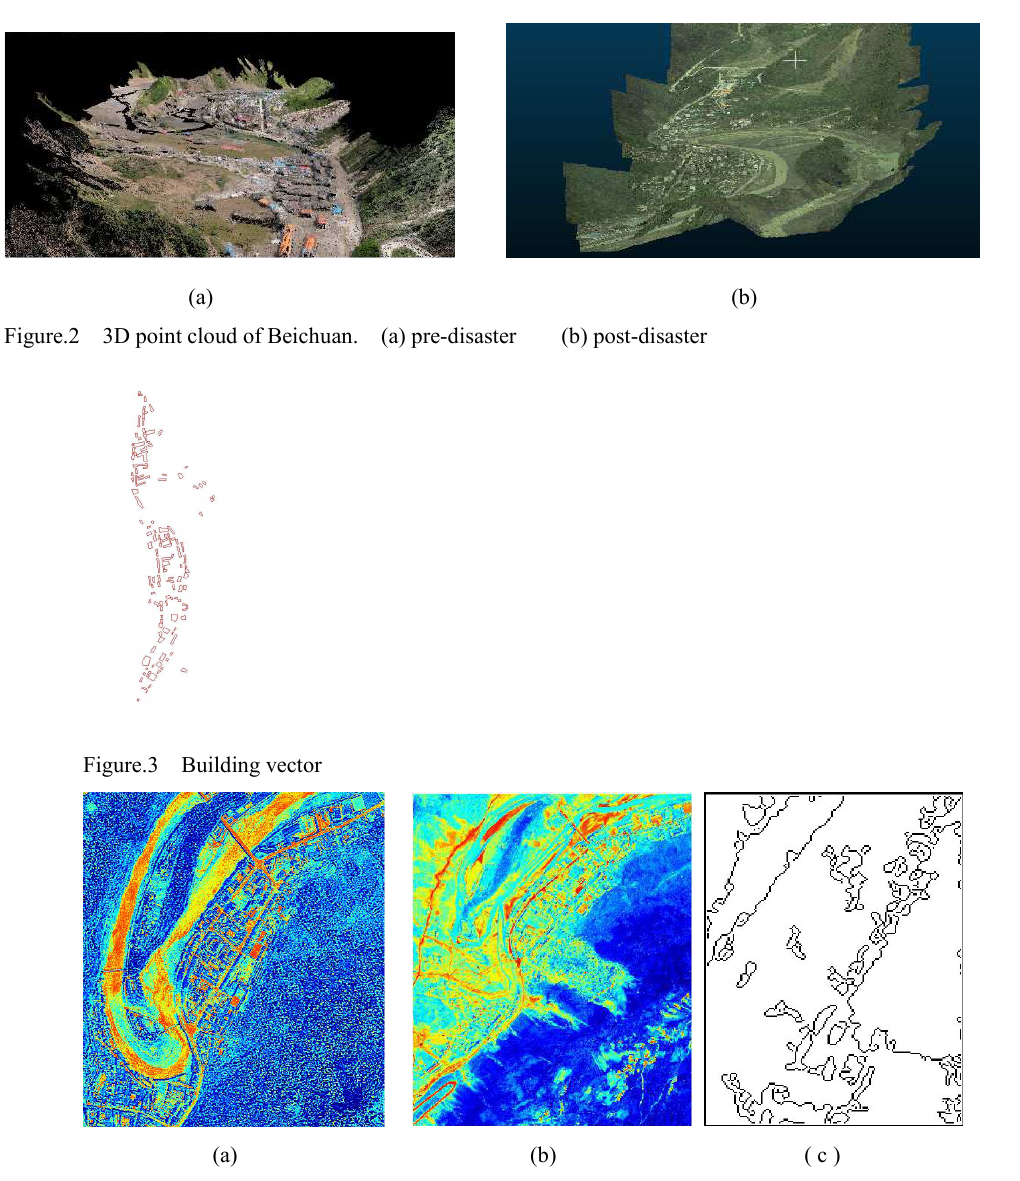
Figure.4 DSM and Change detection image (a) pre-disaster (b) post-disaster (c) Change detection